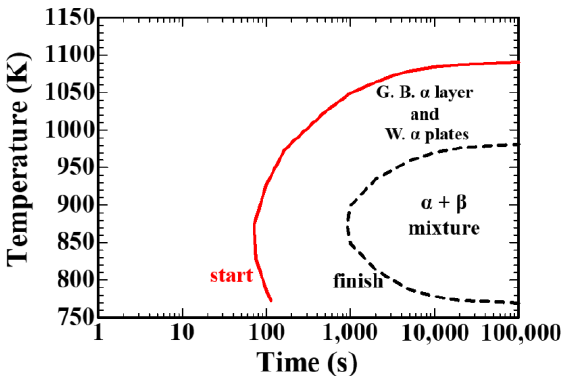
Figure 5. Time – temperature – precipitation diagram for Ti-17 alloy [19].